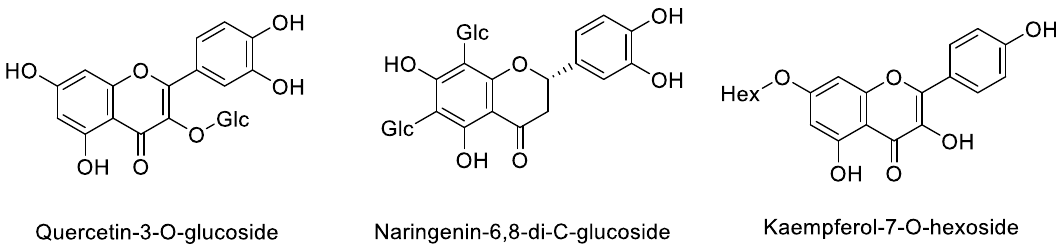
Figure 7. B. retusa fruit and leaves LC-MS Base Peak Ion (BPI) chromatograms. ( A ), Chromatogram of Chart 1. Main compounds identified in in B. retusa stem barks. fruits; ( B ), Chromatogram of leaves.